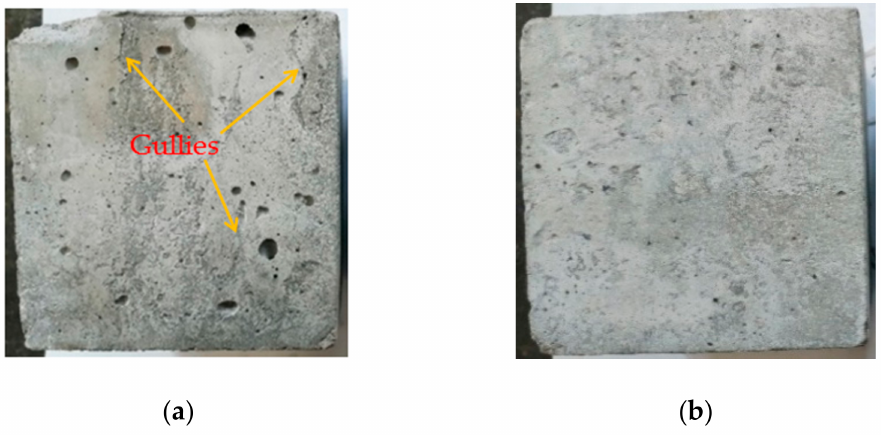
Figure 11. Contrast of morphology of concrete after 100 freeze–thaw cycles: ( a ) Reference group; ( b ) hybrid fiber